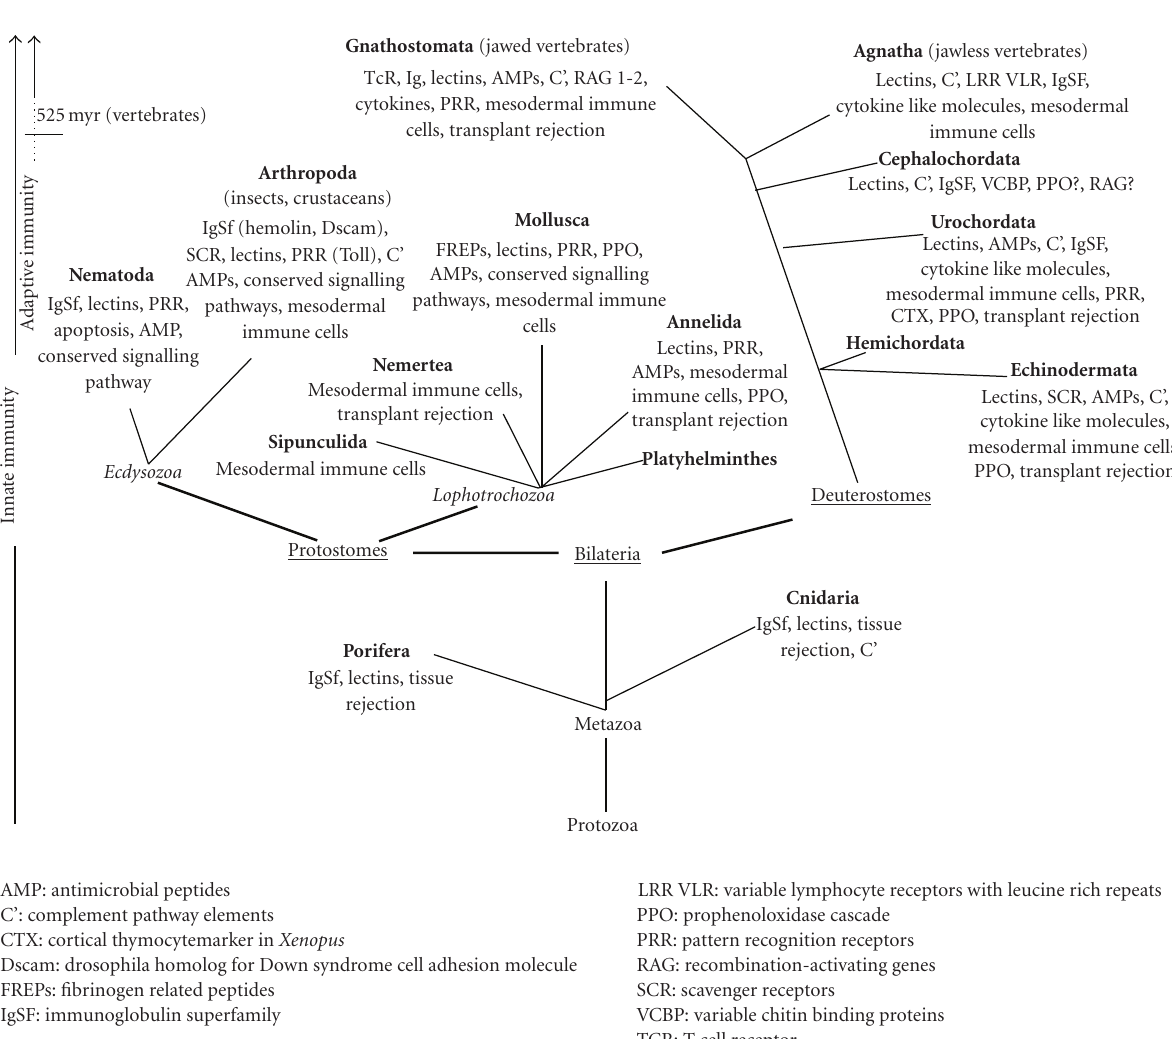
Figure 1: Phylogenetic tree of the animal kingdom highlighting the evolution of key immunological elements. Two arrows on the left side of Figure 1 indicate possible appearance of the two branches of immunity. Innate immunity may be observed along the entire animal kingdom. Traditionally accepted adaptive immunity appeared only in vertebrates, while certain adaptive immune mechanisms may have appeared early at the level of arthropods and molluscs illustrated by dots (below the